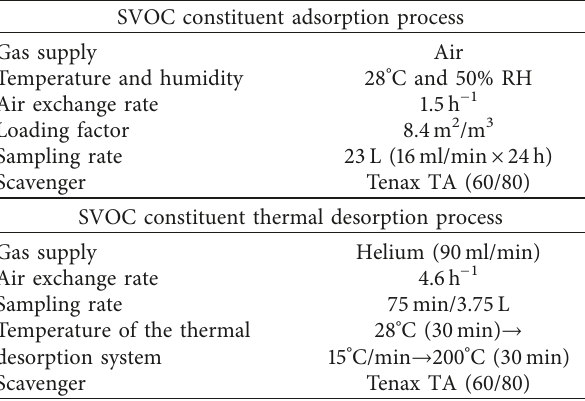
Table 1: Measurement conditions of the thermal desorption test chamber system.